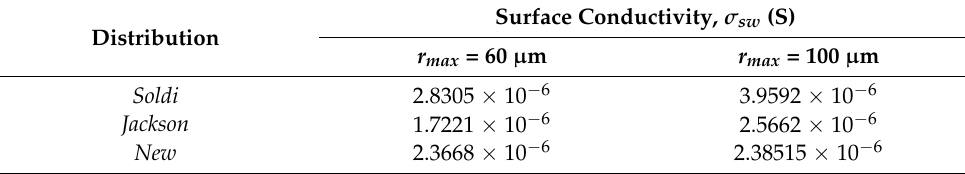
Table 6. Surface conductivity of the model for Soldi , Jackson and New distribution functions with capillaries of alternating radius and model porosity of 18.75% required to match the conductivity of the water-saturated rock measured by Moore et al. [43]. Number of significant figures varies due to the requirement to match conductivity